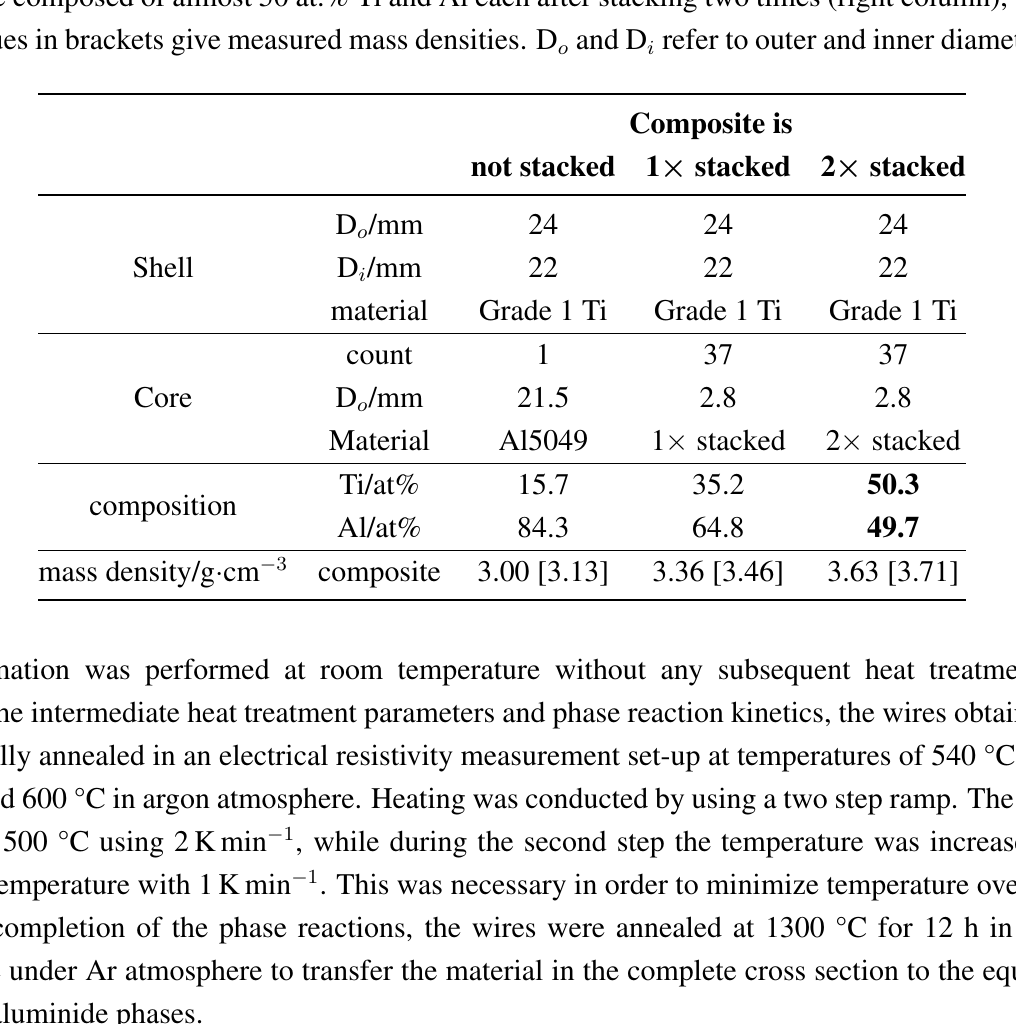
Table 1. Calculation of the adopted processing route from [11,19] leading to a composite wire composed of almost 50 at.% Ti and Al each after stacking two times (right column), the values in brackets give measured mass densities. D